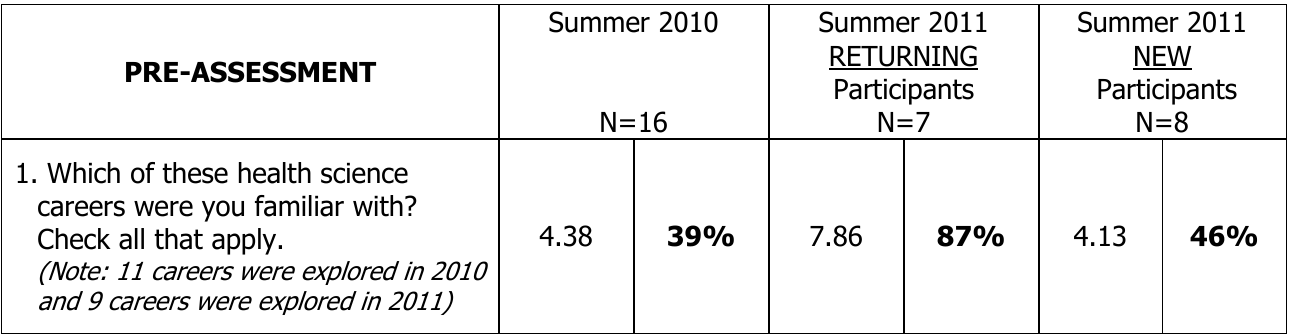
Three-day summer session evaluation data from 2010 and 2011 N=number who attended all days and completed pre- and